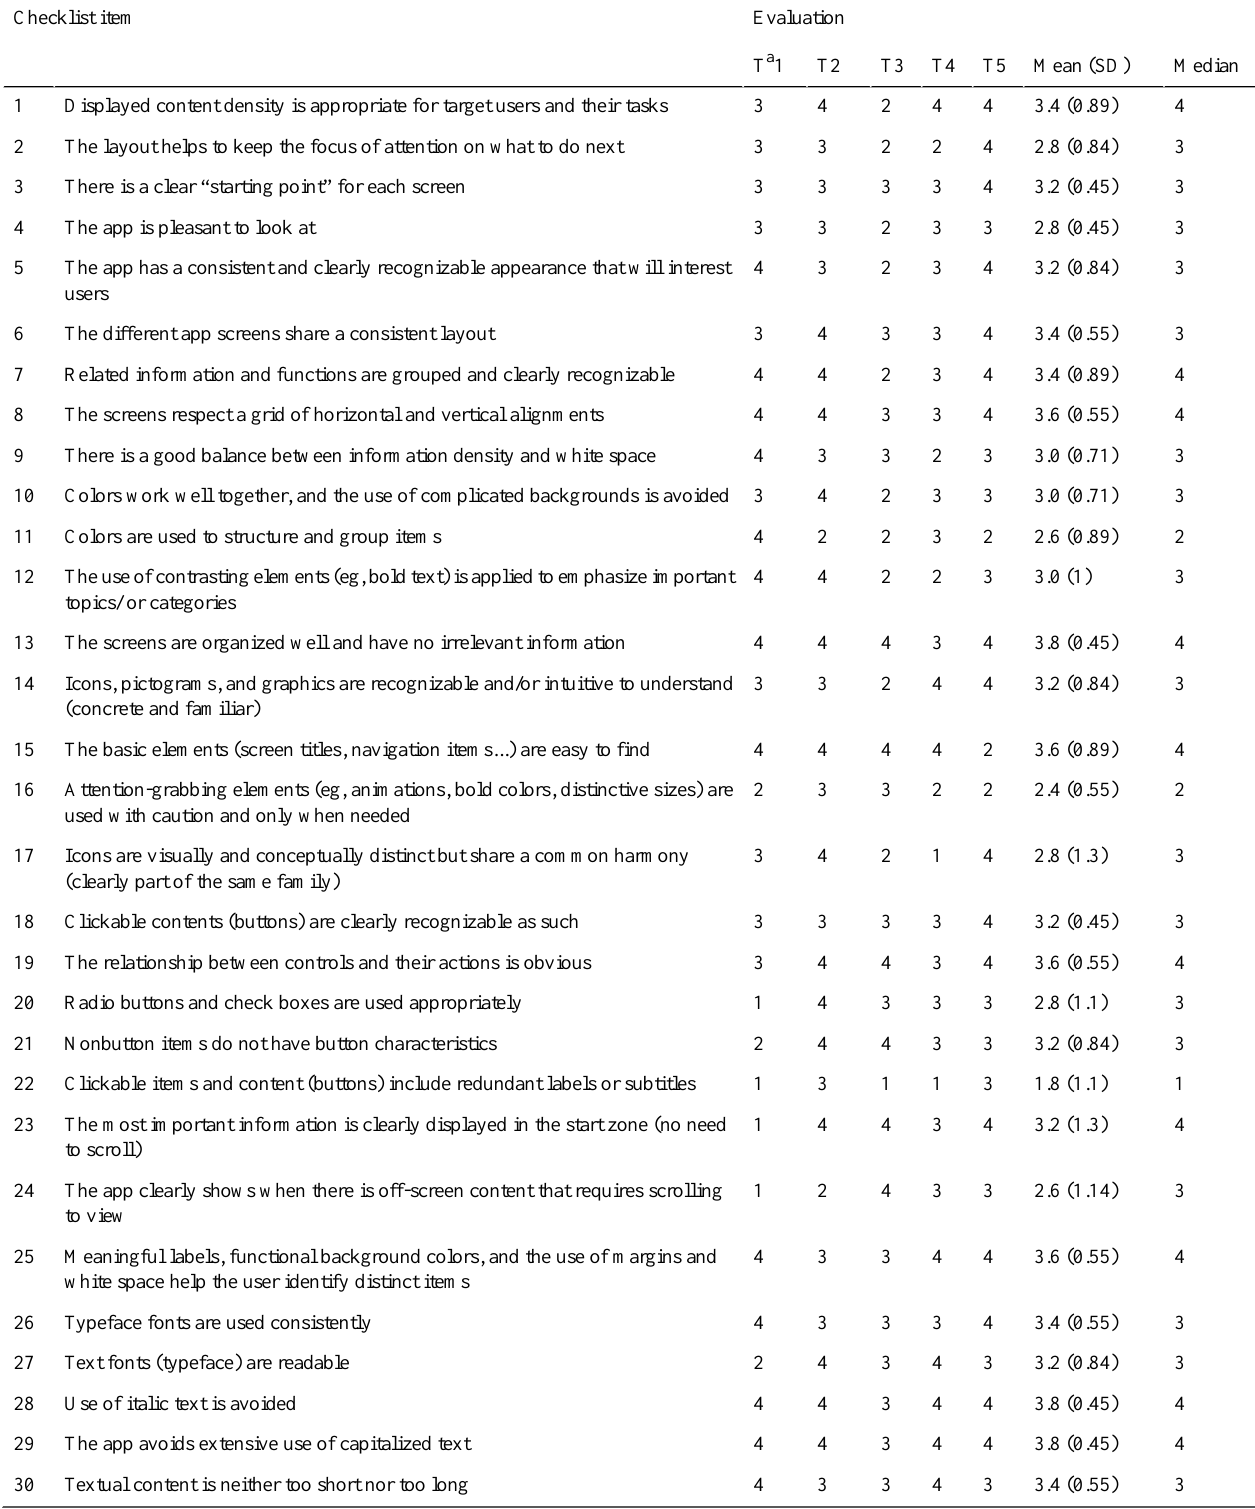
Table 1. Layout and visual design checklist and respective peer review test results. EvaluationChecklist